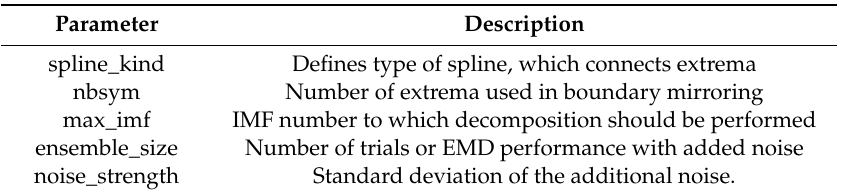
Table 1. EEMD and CEEMDAN parameters description.